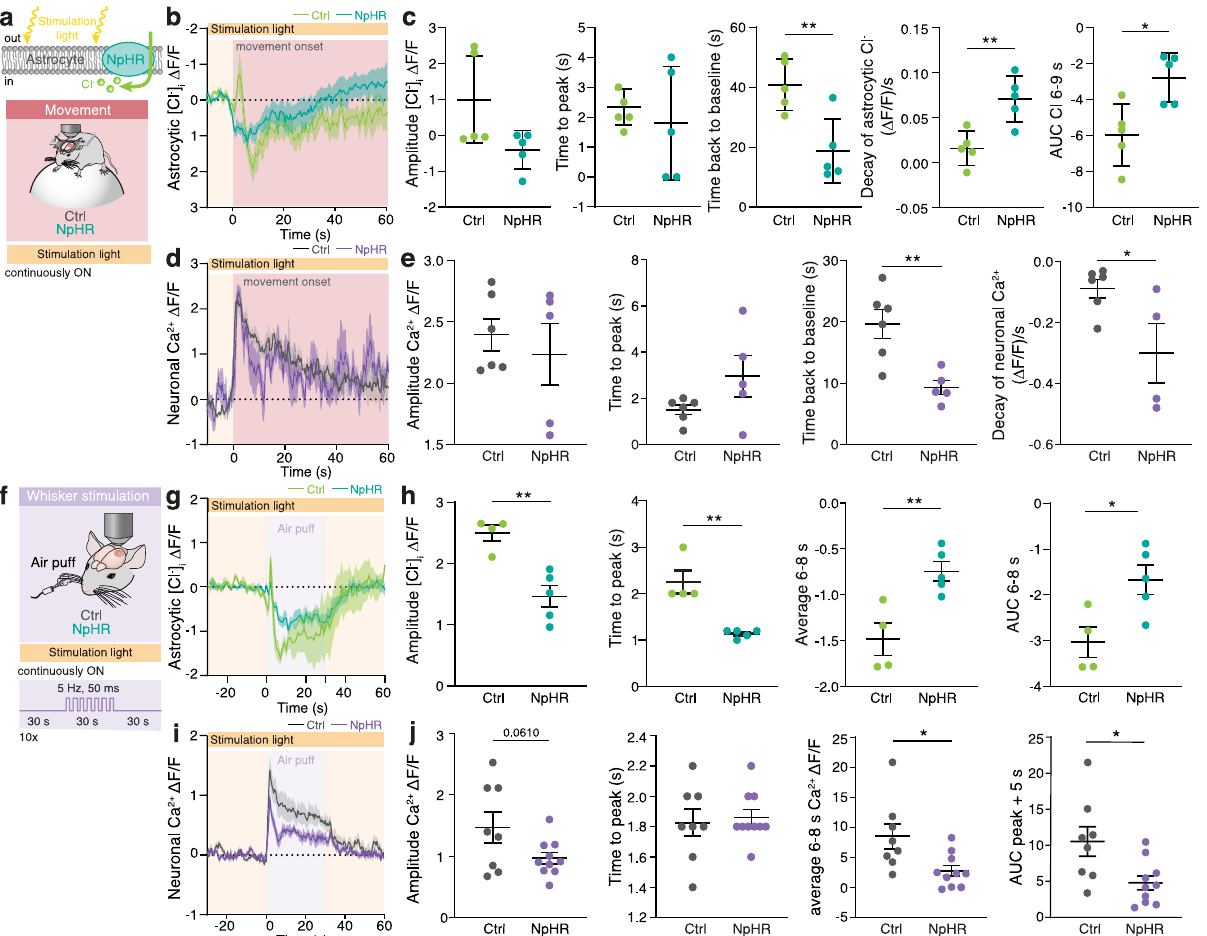
Fig. 3 | Optogenetic elevation of astrocytic [Cl − ] i shortens activation-induced neuronal [Ca 2+ ] i . a The optogenetic Cl − pump was expressed in astrocytes to manipulate [Cl − ] i , while astrocytic [Cl − ] i or neuronal [Ca 2+ ] i was imaged. As a negative control, light stimulation was applied to mice not expressing NpHR3.0. Mice were voluntarily running on a Styrofoam sphere. b Average astrocytic [Cl − ] i traces during transition from stationary to mobile, recorded during continuous light stimulation of NpHR3.0 in astrocytes with or without NpHR3.0; shading indicates ±SEM. N =6 ctrl/5 NpHR3.0. c Peak amplitude of astrocytic [Cl − ] i upon movementonset;timeto peakof astrocytic[Cl − ] i ;timetobaseline;slopeof decay, and area under the curve (AUC) from 6 to 8s, data represent mean±SEM. N =5 ctrl/5 NpHR3.0, un-paired two-tailed t -test. p =0.9238, p =0.6626, ** p =0.0068, ** p =0.0049 * p =0.0119. d Average neuronal [Ca 2+ ] i trace during transition from stationary to mobile, recorded during continuous light stimulation of NpHR3.0 in astrocytes with or without NpHR3.0; shading indicates ±SEM. N =3 mice. e Peak amplitude of neuronal [Ca 2+ ] i upon movement onset; time to peak; recovery time to baseline; slope of decay, data represent mean±SEM. N =6 ctrl/5 NpHR3.0,